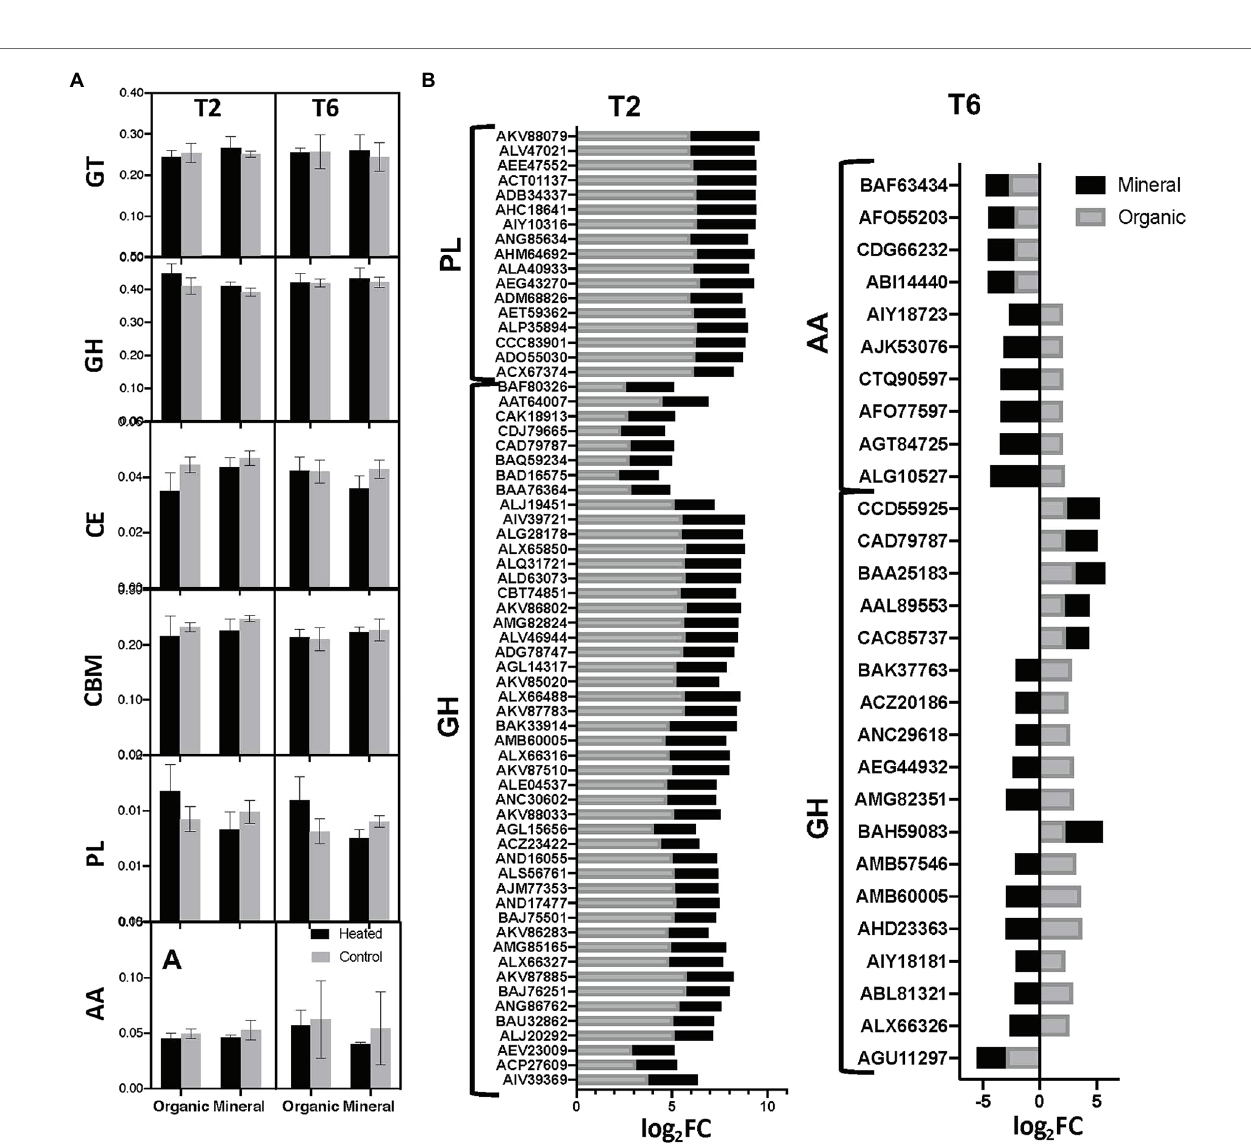
FIGURE 2 | carbohydrate metabolism division (Bottom Panel); (C) Genes that are differentially expressed between heated and control plots in organic and mineral horizons in T2 and T6 time points. Edge R analyses was done on KEGG transcripts that were annotated as genes involved in metabolism. Differential expression is measured as log of the fold change ratio (FC). So, a log 2 FC of +2 means twice the abundance of the gene in heated plots compared to control, while a log 2 FC of − 2 indicates twice the abundance of the gene in control plots compared to heated. All differential expression is measured at FDR 5%. Note that +ve and − ve FC ratios are relative to the specific heated and control plots that are used in the pair-wise comparisons.